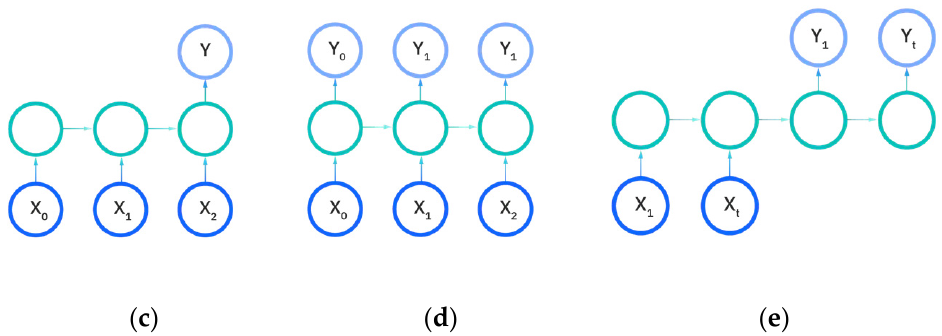
Figure 11: Input and output dimensions in RNN: ( a ) One-to-One; ( b ) One-to-Many; ( c ) Many-to- one; ( d ) Many-to-many; ( e ) Many-to-many (future prediction) [24].